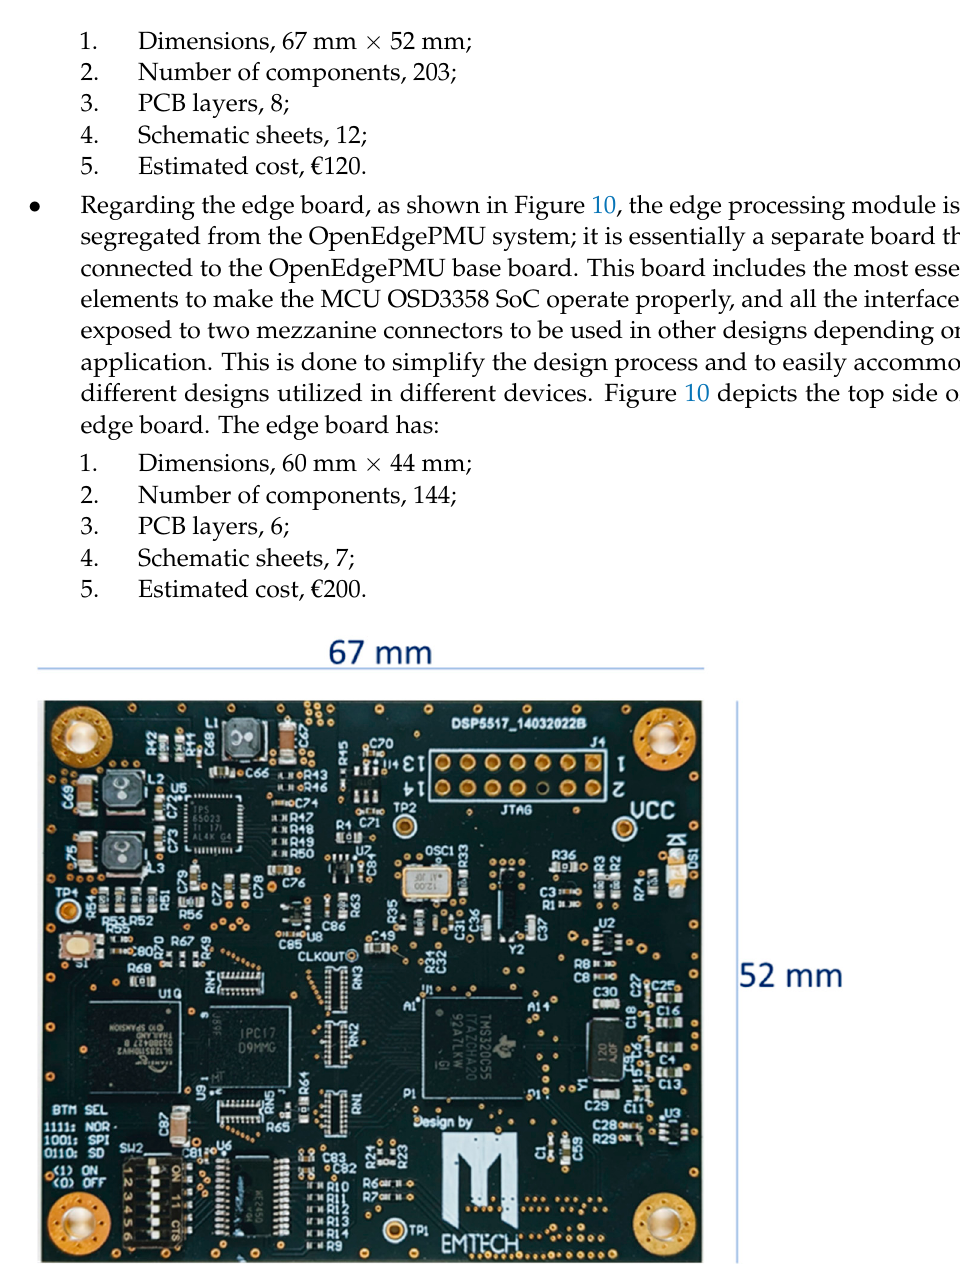
Figure 9. Implementation of the DSP module board, top side.